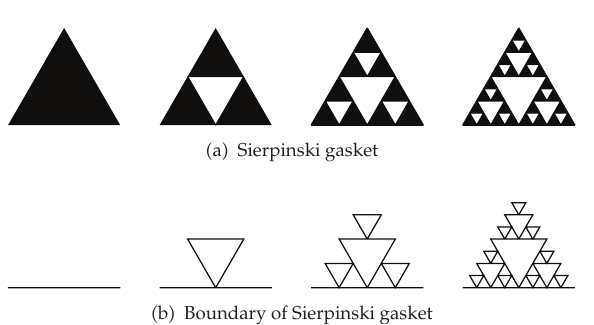
Figure 2: The Sierpinski gasket and its interior boundary lines (cid:3) the first four steps (cid:4)